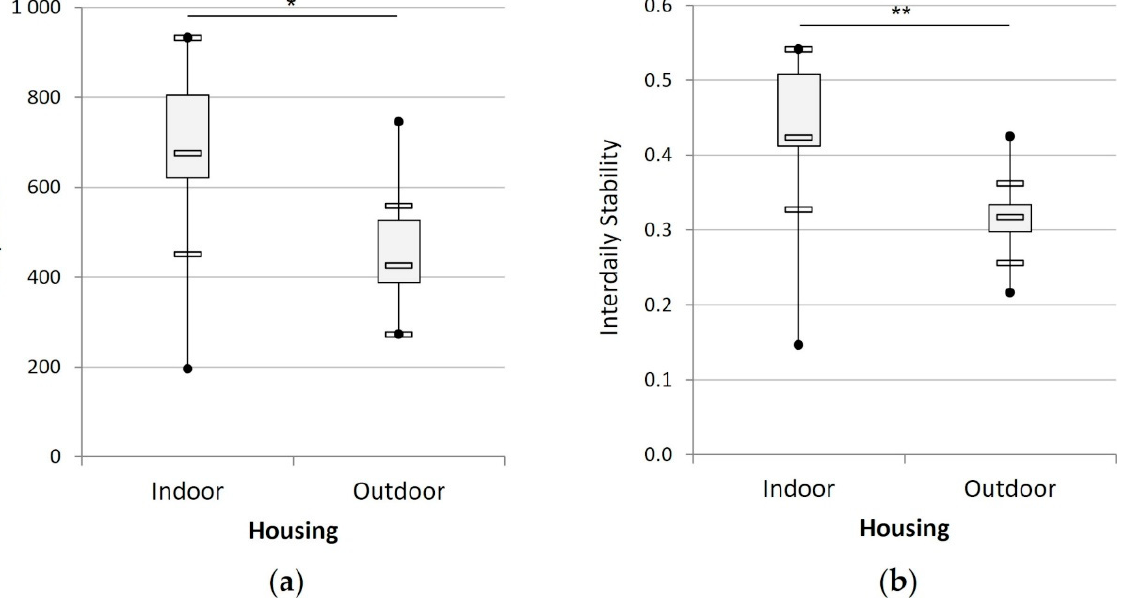
Figure 3. Mean amplitude ( a ) and interdaily stability ( b ) of the activity rhythm of the cats according to their housing condition (indoors (n = 15) versus outdoors (n = 8)). (*) indicates p < 0.05, (**) indicates p < 0.01.